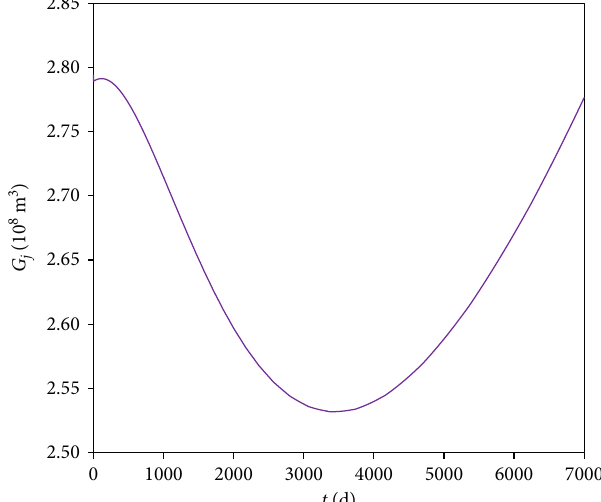
Figure 31: Relation curves of p / ð μ Z Þ and μ Z vs. pressure ( p ) for Case 3. for Case j